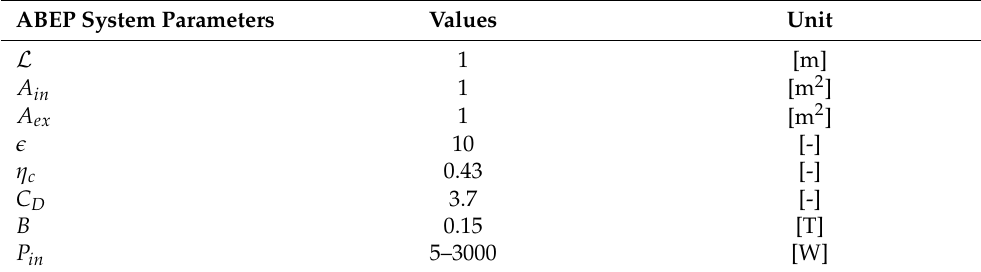
Table 1. Main spacecraft and ABEP system parameters used for analysis. ABEP System